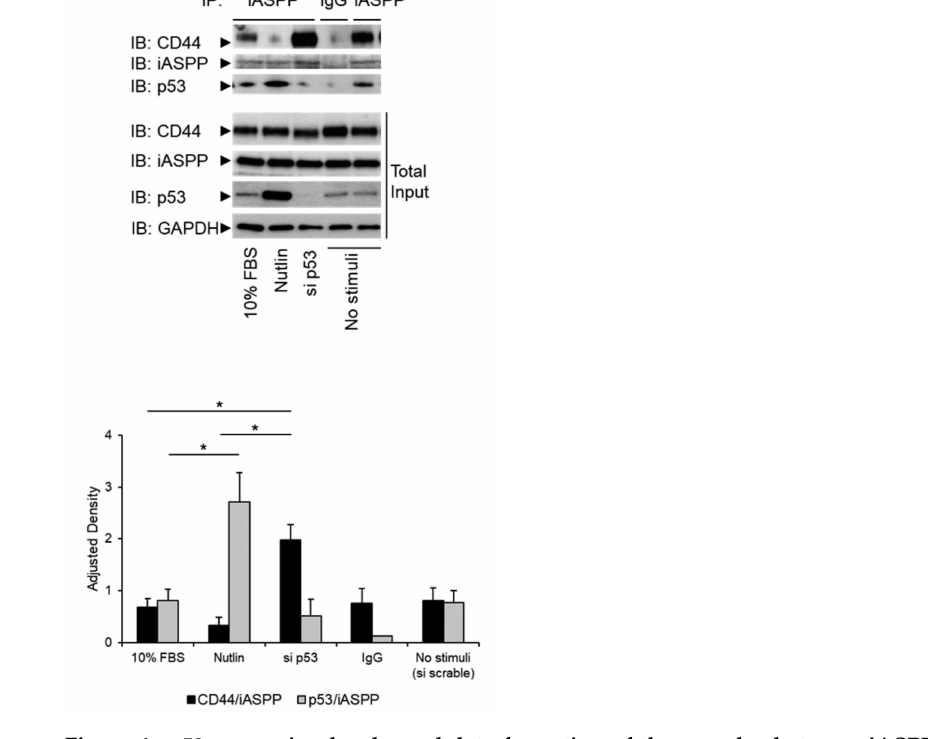
Figure 4. p53 expression levels modulate formation of the complex between iASPP and CD44. hTERT-BJ cells, treated with p53 siRNA, or not, were stimulated with 10% FBS or 10 nM Nutlin. Lysates were subjected to immunoprecipitation (IP) with an iASPP antiserum, followed by im- munoblotting with antibodies against iASPP and p53. Quantification of the data is shown below the blot. The data are plotted in bar graphs representing the mean ± SD of at least three independent experiments (* p < 0.05, Student’s t -test). The uncropped blots are shown in File